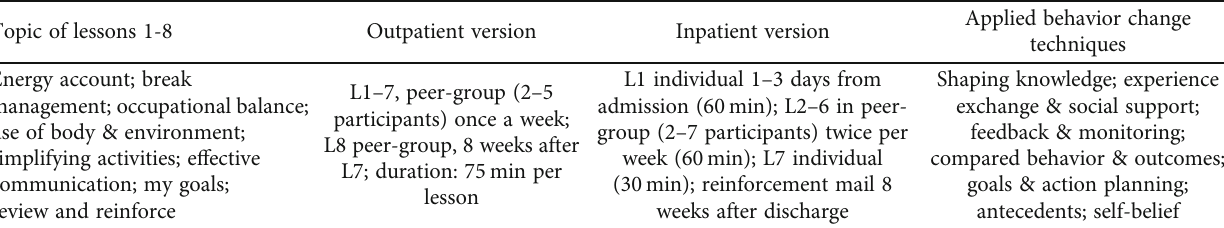
Table 1: Description of energy management education